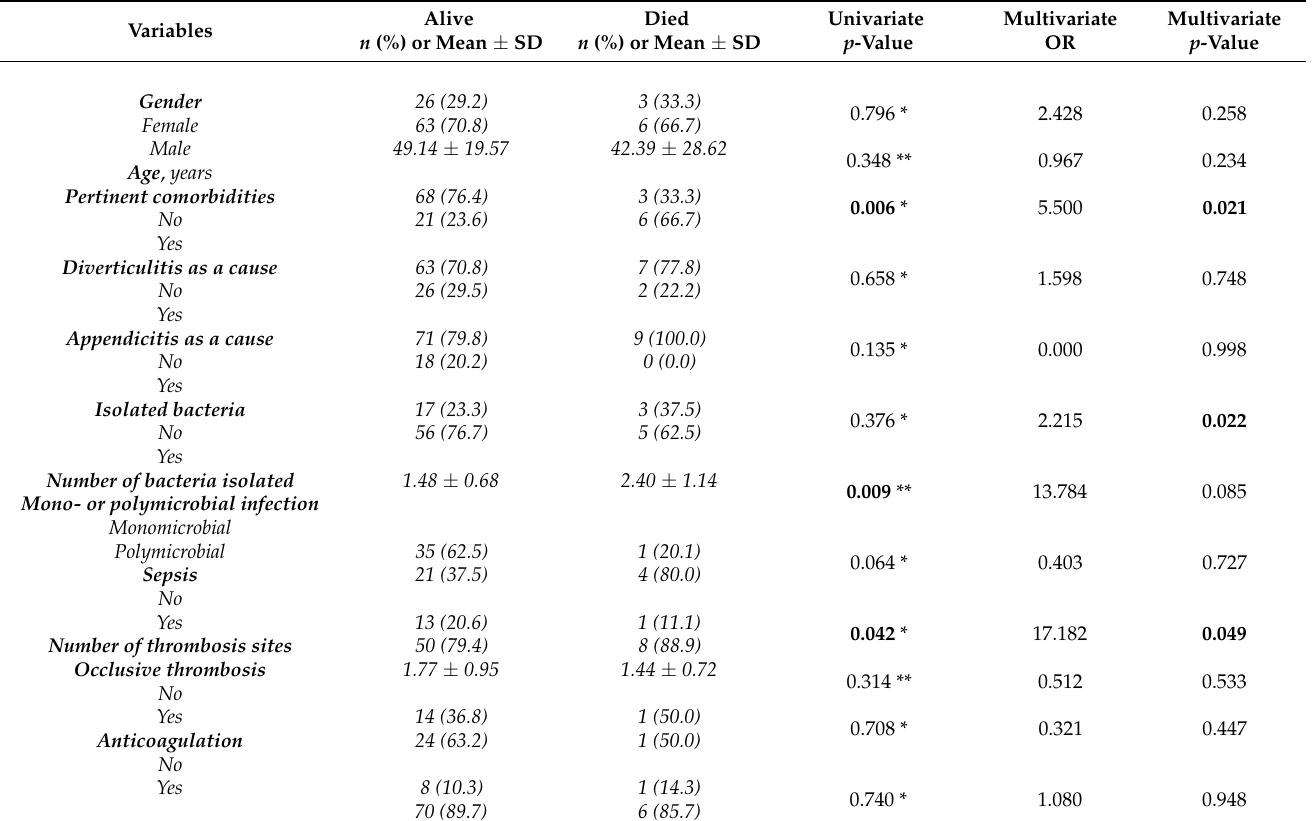
Table 3. The complete list of risk factors and their association with mortality in our systematic review.